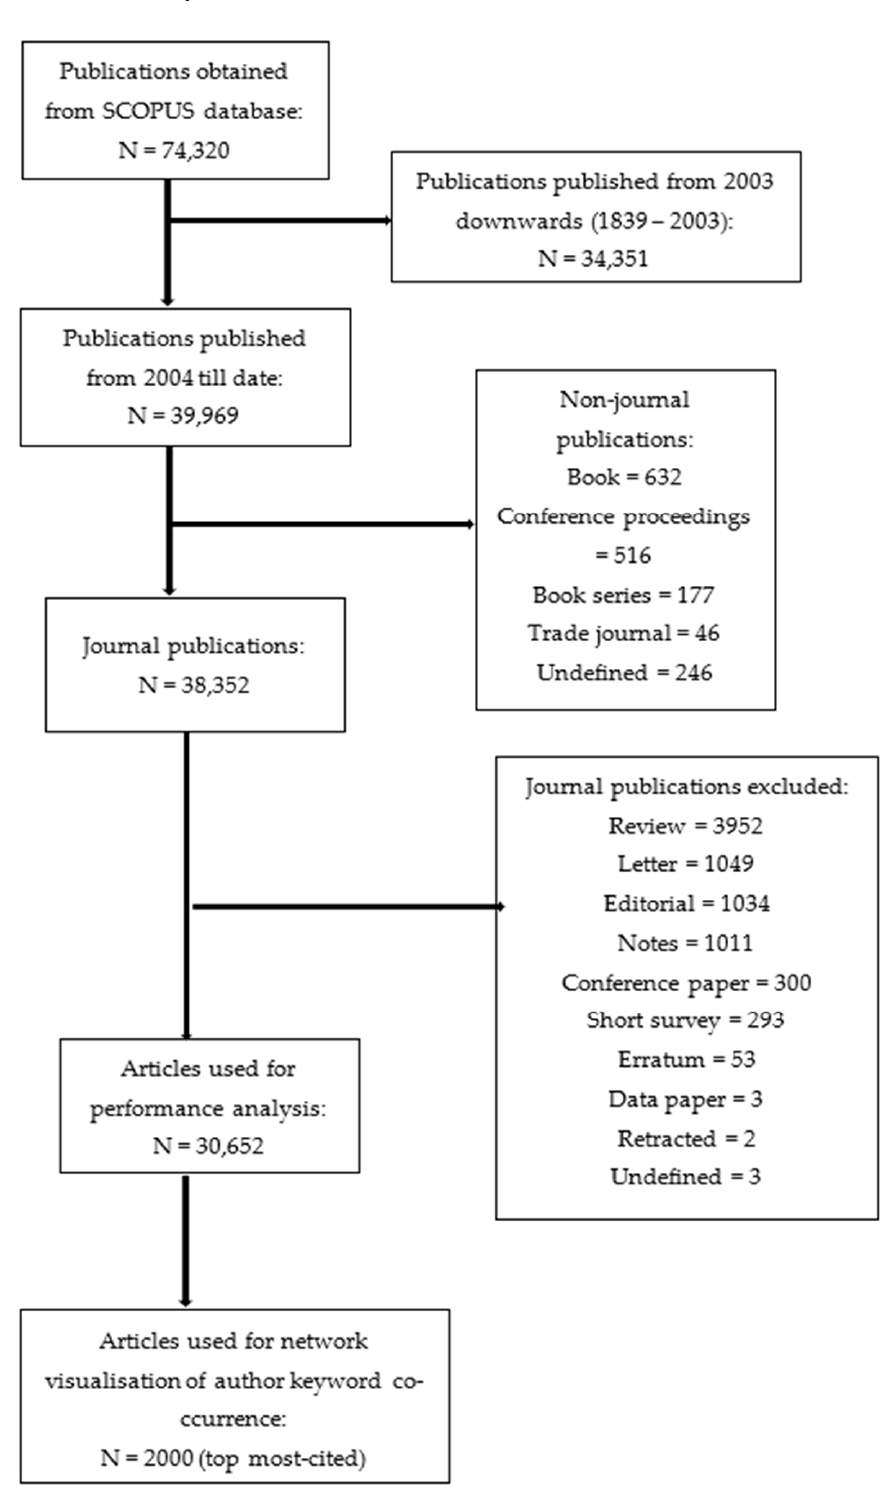
Figure 1. Flow chart for collecting articles for data analysis.